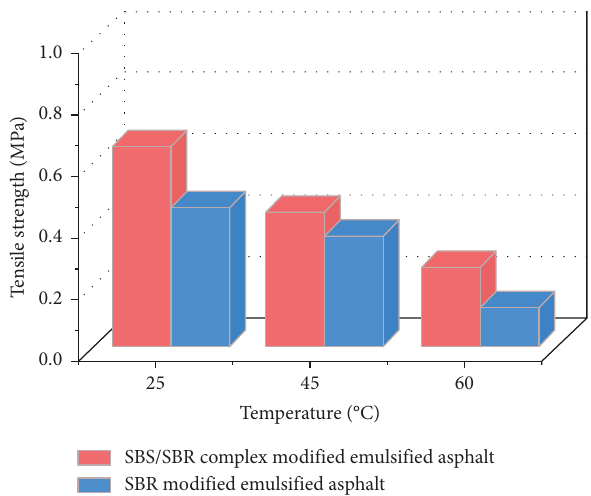
Figure 18: Variation of tensile strength of diferent modifed emulsifed asphalt with